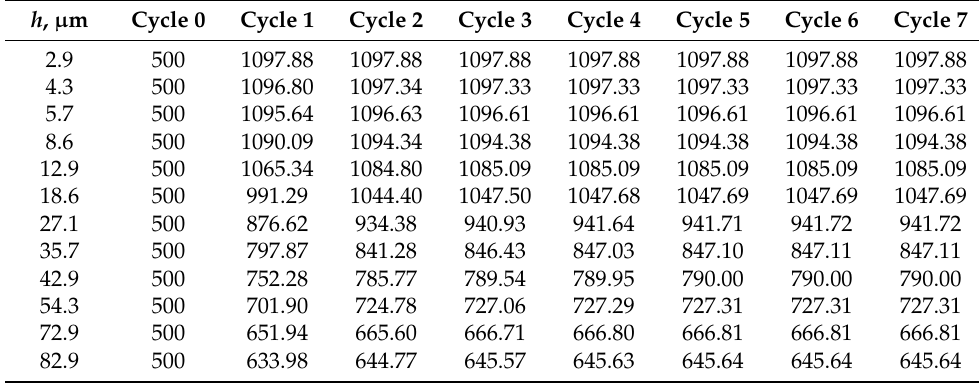
Table 2. The results of the recursive calculation in every cycle,